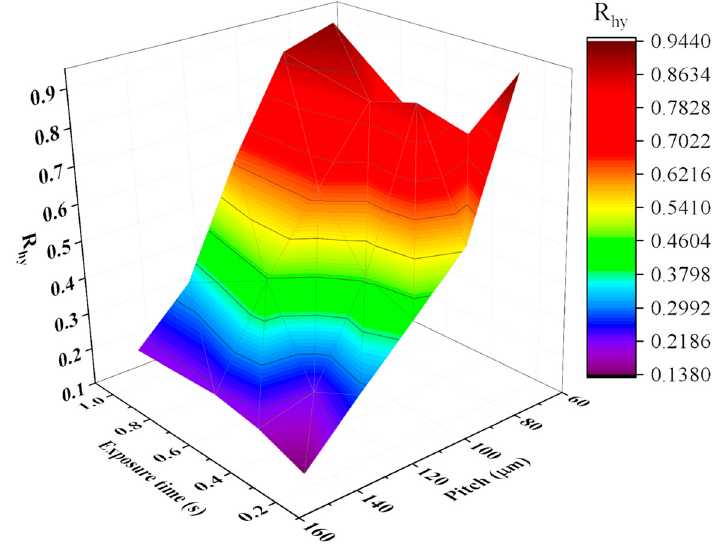
Figure 8. 3D colormap of the product fingerprint (R hy ) as a function of exposure time and pitch of Gaussian holes.